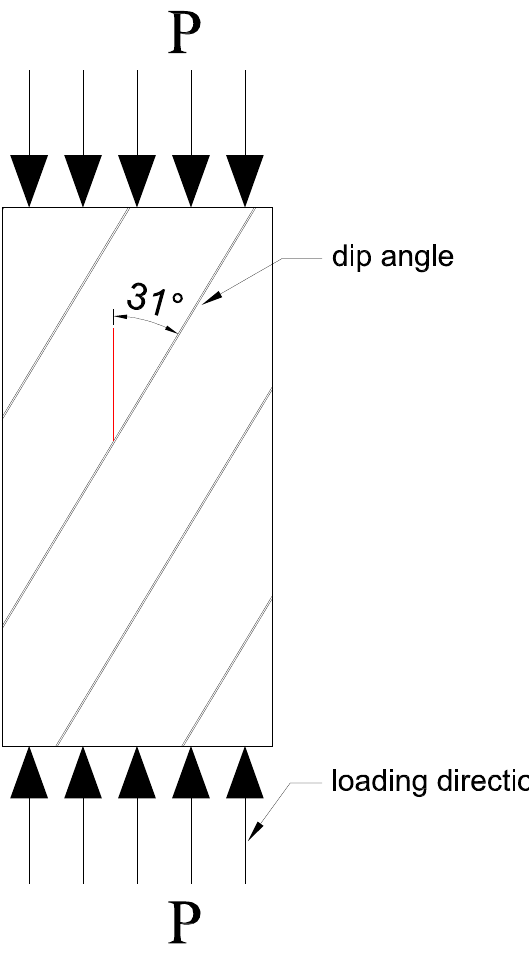
Figure 3. Schematic diagram of red shale joints and the orientation of the load. The rock samples soaked for different times or drying on drying box had their uniaxial compressive strength tested on the Instron 1342 testing machine (Instron, UK). The loading pattern was set to displacement control with the rate of 0.3 mm/min. Three samples were selected for the uniaxial compression test for each immersion time. The uniaxial compressive strength of the rock samples with the same immersion time was averaged. All results are shown in Figure 4. When immersion time was less than two hours, the uniaxial compressive strength of the rock samples sharply decreased from 22.22 MPa to 7.94 MPa. The uniaxial compressive strength of rock samples soaking for over 24 h was only 5.04 MPa, equivalent to a quarter of a rock sample’s strength in natural state. When immersion time exceeded 72 h, water-saturated rock samples partly disintegrated before loading and the uniaxial compressive strength is the lowest one and only about 1.56